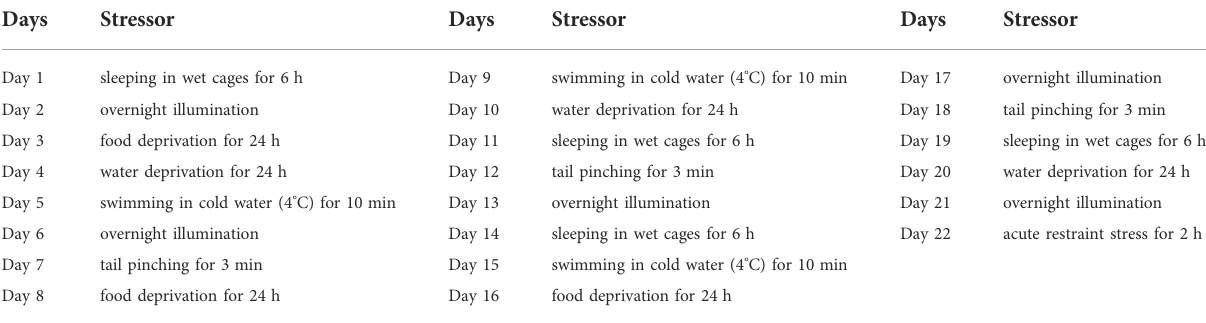
TABLE 1 The protocol of chronic acute combining